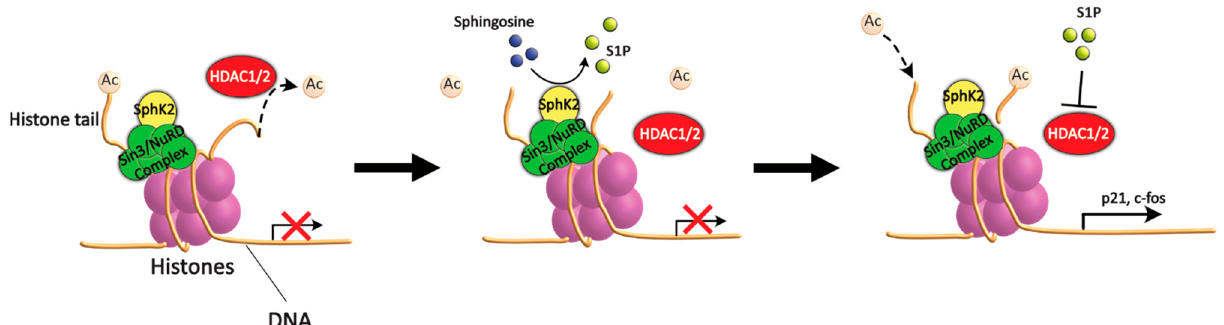
Figure 3. Schematic representation of HDAC inhibition by S1P. HDAC1/2 deacetylate histones as part of the Sin3 or NuRD repressor complexes localised at the promoters of target genes. SphK2 binds to said repressor complexes. SphK2 then synthetises S1P that, in turn, binds to and inhibits HDAC1/2, preventing deacetylation and thus increasing overall gene